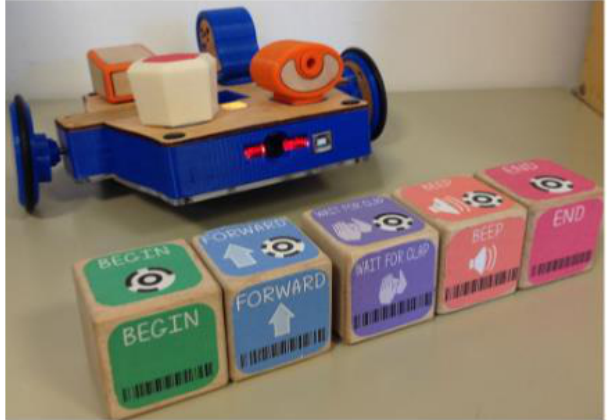
Figure 21. Kiwi robotics kit and CHERP programming blocks [39].